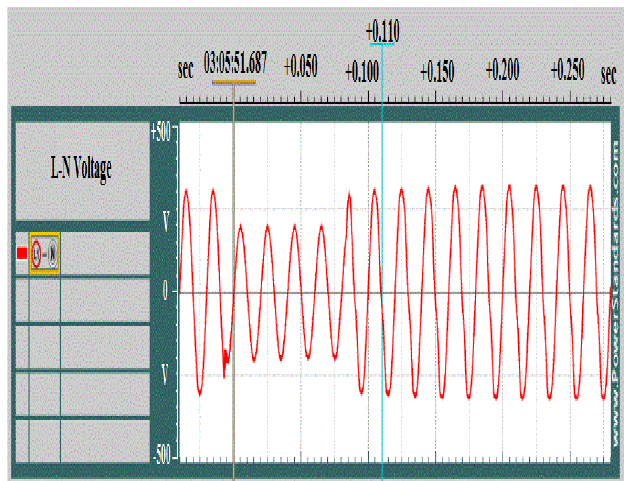
Fig. 4. Power Quality Monitor with PQube voltage sag condition of signal (2015/11/08) Fig. 5. illustrates that first component imf1 the noise (lowest magnitude and highest frequency signal) on the line (L1-N). Lower order of imfs means high frequency and oscillation higher order otherwise.